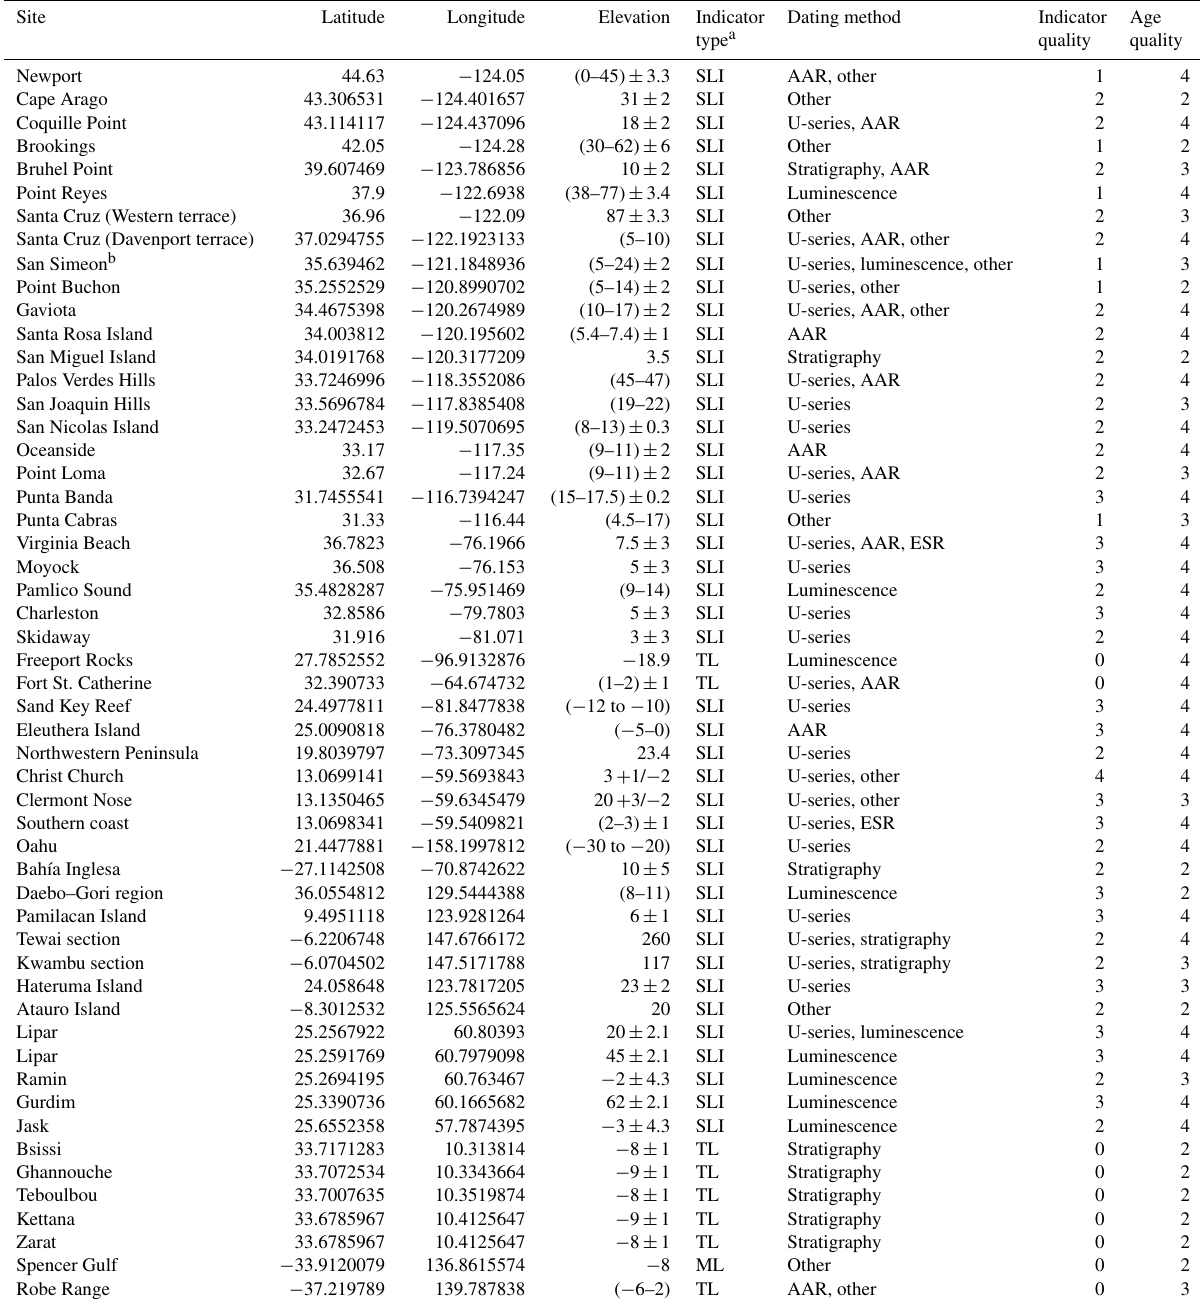
Table 1. The location name, latitude and longitude, elevation, indicator type, dating method, and assigned elevation and age quality ratings for marine isotope stage 5a